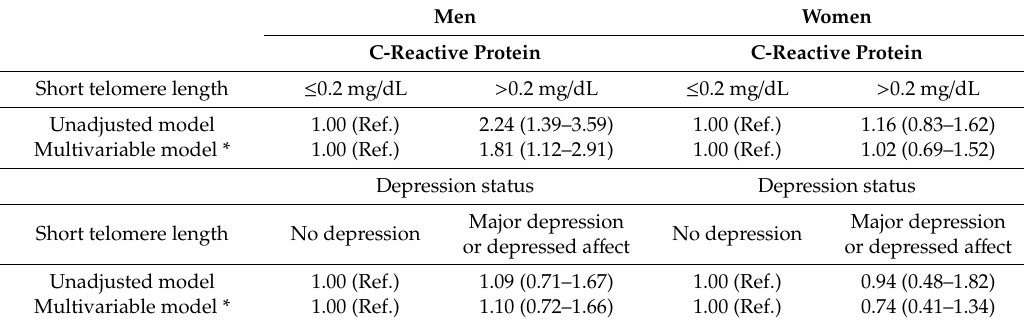
Table 3. Independent e ff ects of C-reactive protein and depression with short telomere length.